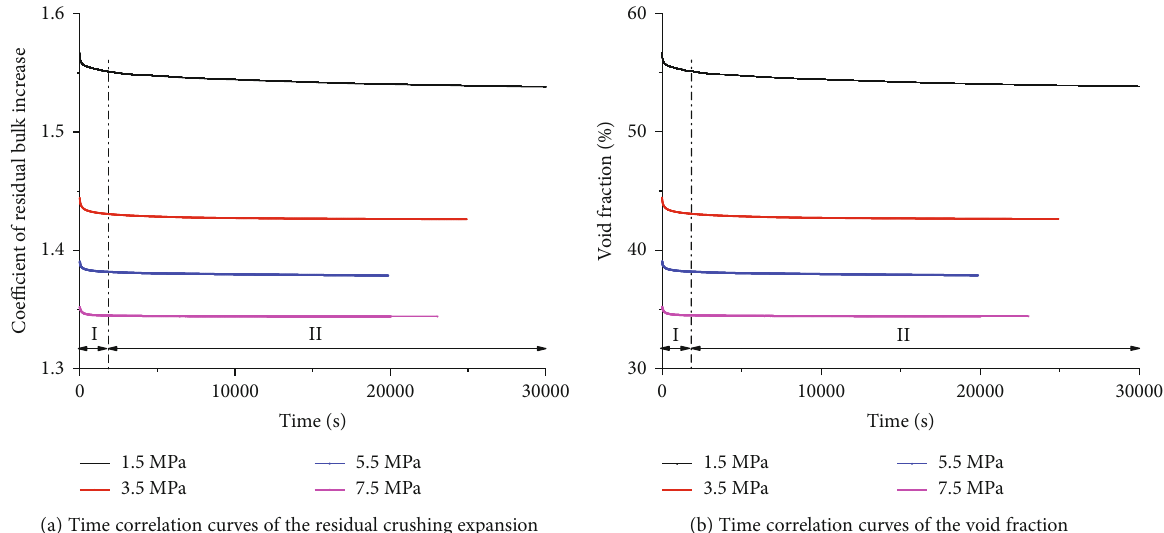
Figure 7: Time correlation curves of the amount of residual crushing expansion and void fraction for caving sandstone samples of di ff erent axial stresses. Table 4: Grain size distribution and fractal dimensions of crushed sandstone samples of di ff erent axial stresses before and after compression. Axial